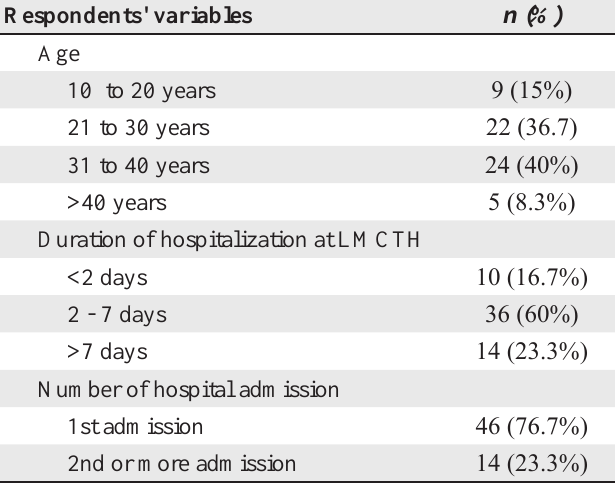
Table 1: Some variables of the